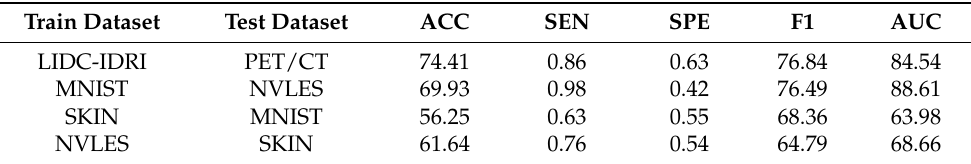
Table 11. Analytical metrics for the FF-VGG19 network when evaluating on alternate acquisition